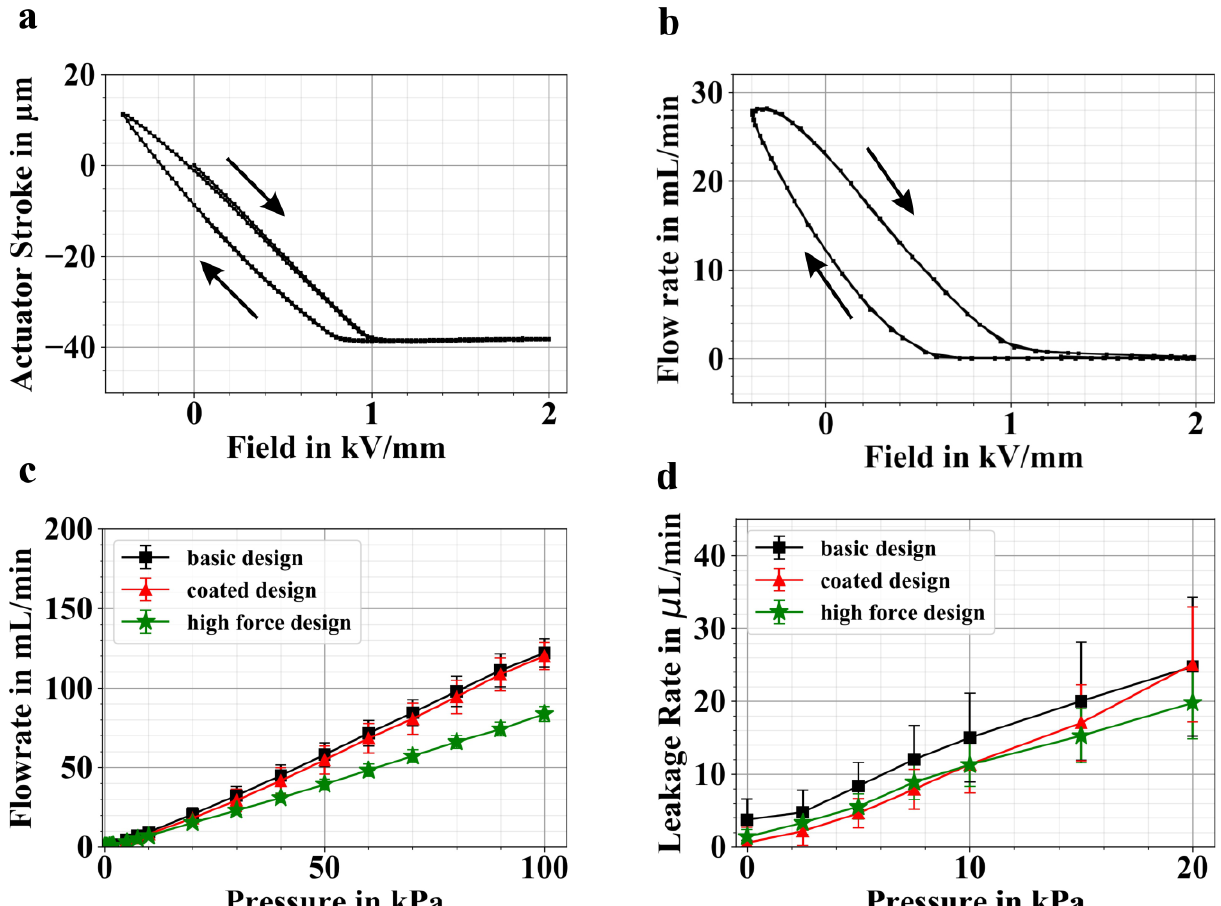
Figure 9. ( a ) Typical stroke measurement of the NO valve. At an applied field of approximately 1 kV/mm, the actuator diaphragm sits on the valve seat, and downwards movement is inhibited. ( b ) Typical flow characteristic of an NO valve at an inlet pressure of 20 kPa showing complete blockage of the fluidic path at approximately 1.6 kV/mm and a maximum open flow of 27 mL/min. ( c ) Average pressure-dependent flow rate in non-actuated state with an applied inlet pressure of up to 100 kPa. Error bars depict standard deviations. ( d ) Average pressure-dependent leakage with up to 20 kPa inlet pressure. Error bars depict standard deviations.